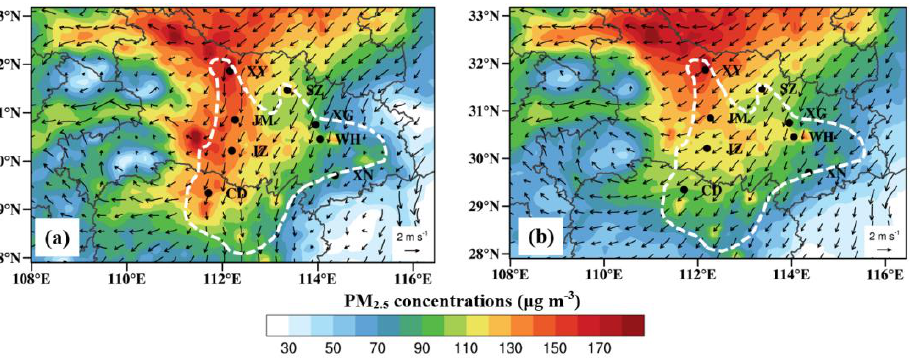
Figure 3. Distributions of the averaged near-surface PM 2.5 concentrations (color shading) and wind fields (arrows) during 4–9 January 2019 in ( a ) control experiment (CE) and ( b ) rising‐hgt experiment (RHE).